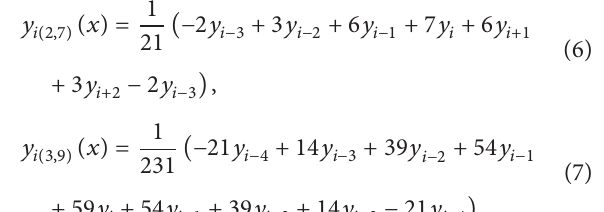
gauge away from the flapper surface) and (2) for decreasing ones, respectively. It is obvious that the collected data